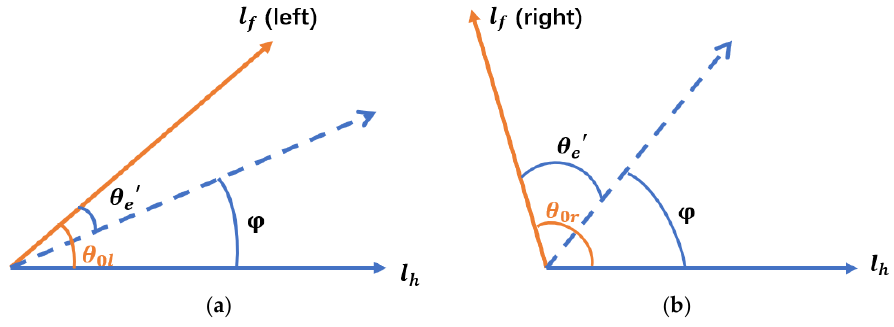
Figure 4. Direction correction diagram: ( a ) left view; ( b ) right view.